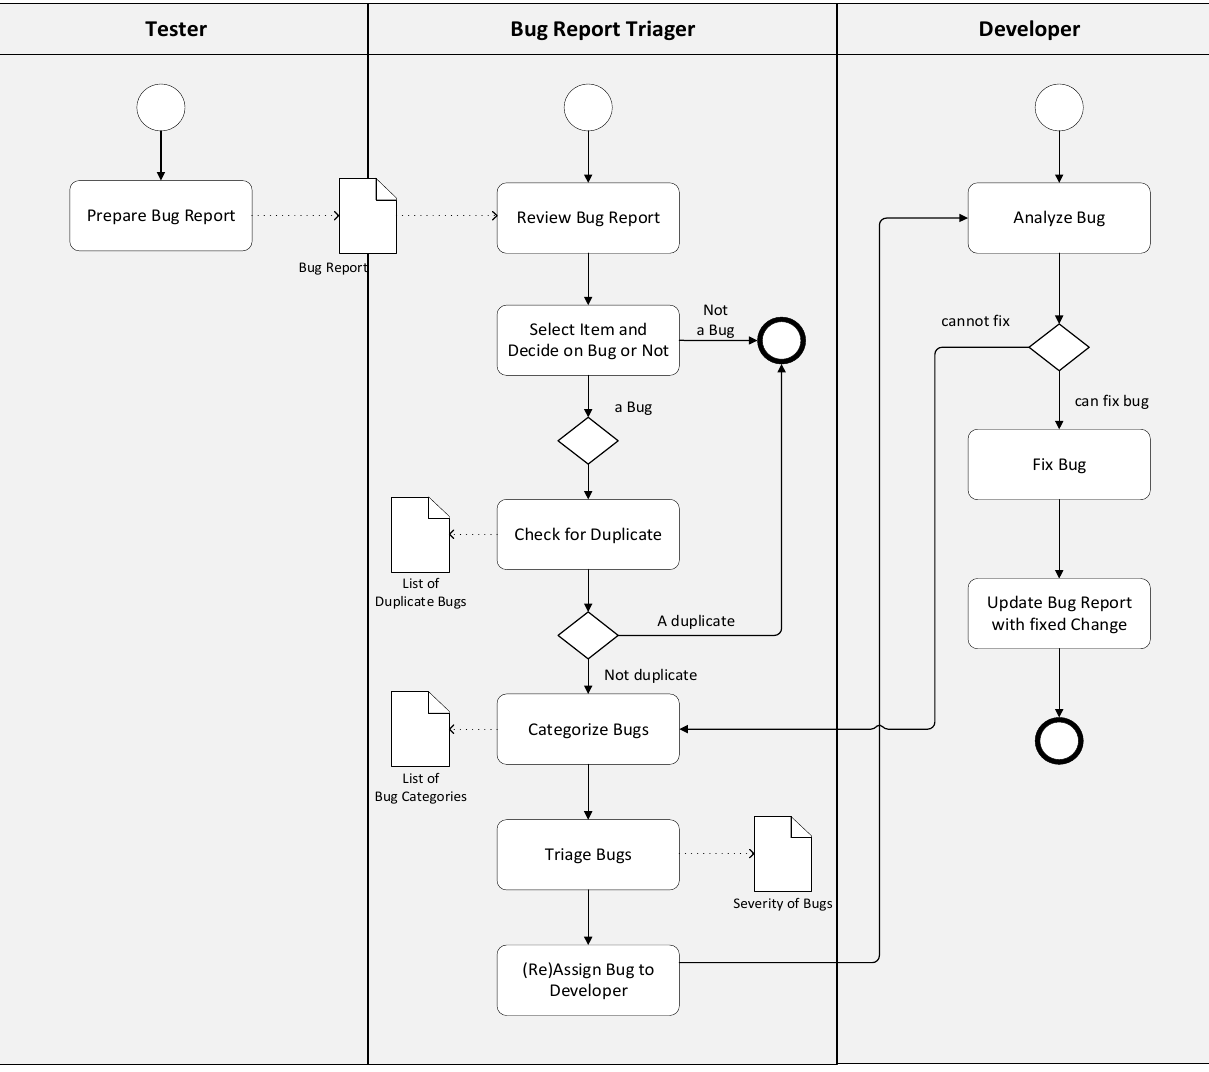
Figure 1. Bug classification process.